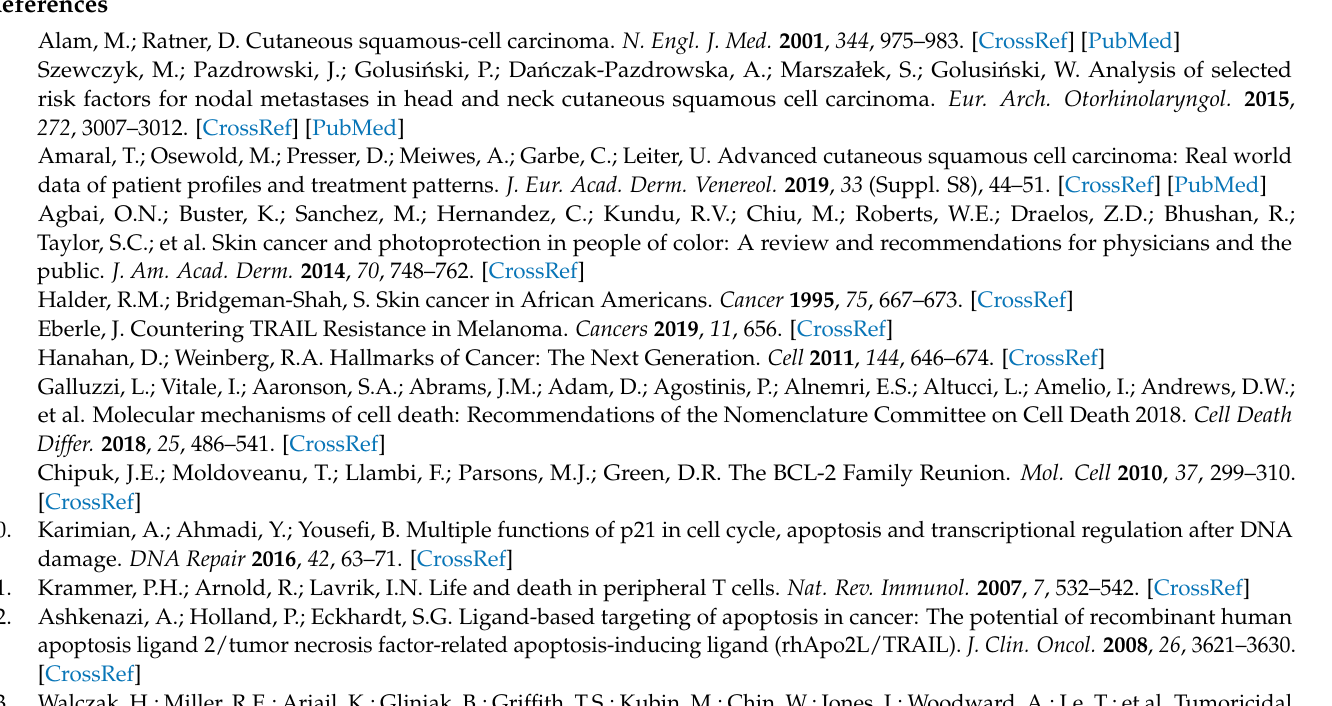
Figure S3: Apoptosis and cell viability in HaCaT cells in response to DKPs, Figure S4: Dose de- pendency of ROS production for DKP-071 and Figure S5: Time dependency of ROS production for DKP-071 (a) 1–4 h (b) 24